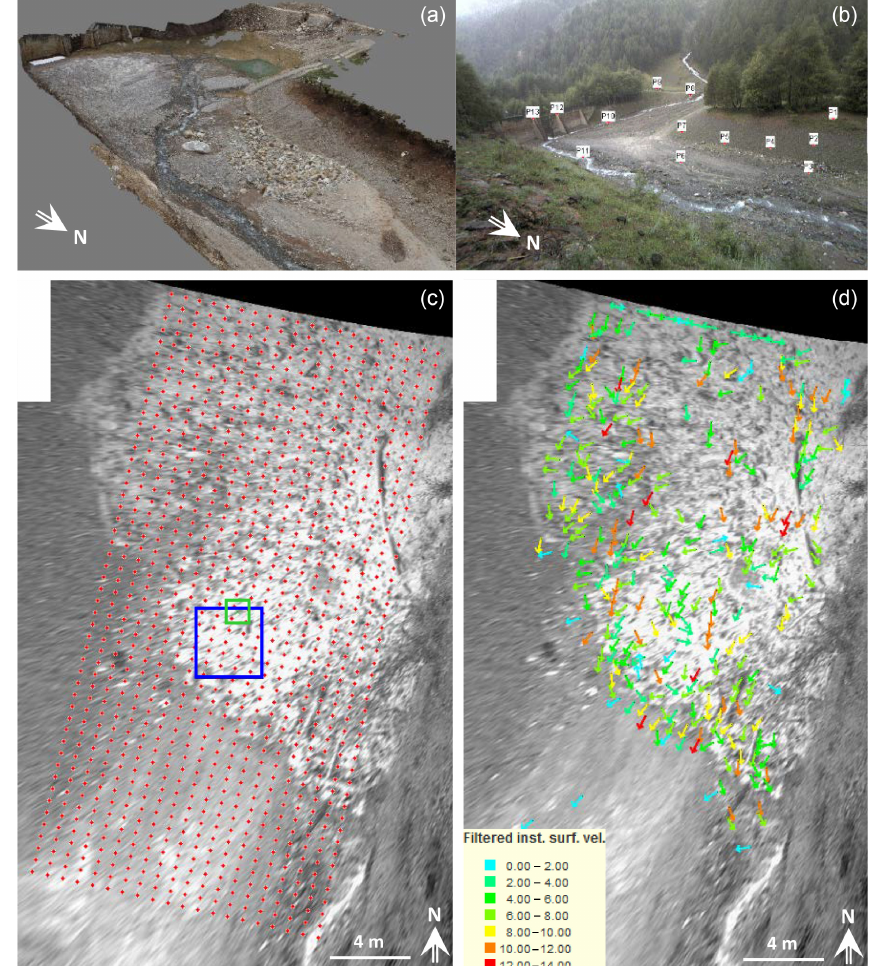
Figure 2. Example of (a) a SfM point cloud used as a post-event reference, (b) the undistorted camera image with the reference points, (c) the orthorectified image during the 2013 debris-flow front with the sampling grid, interrogation area (IA; green) and the search area (SA; blue), and (d) the instantaneous surface velocity